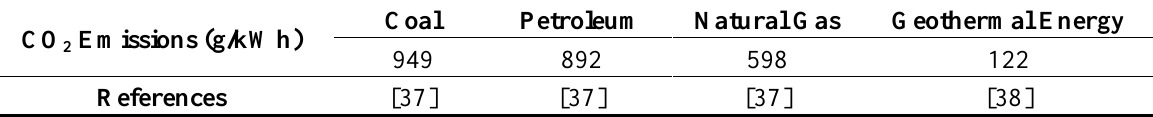
Table 1. CO emissions for kWh by coal, petroleum, natural gas and geothermal energy [37,38]. 2